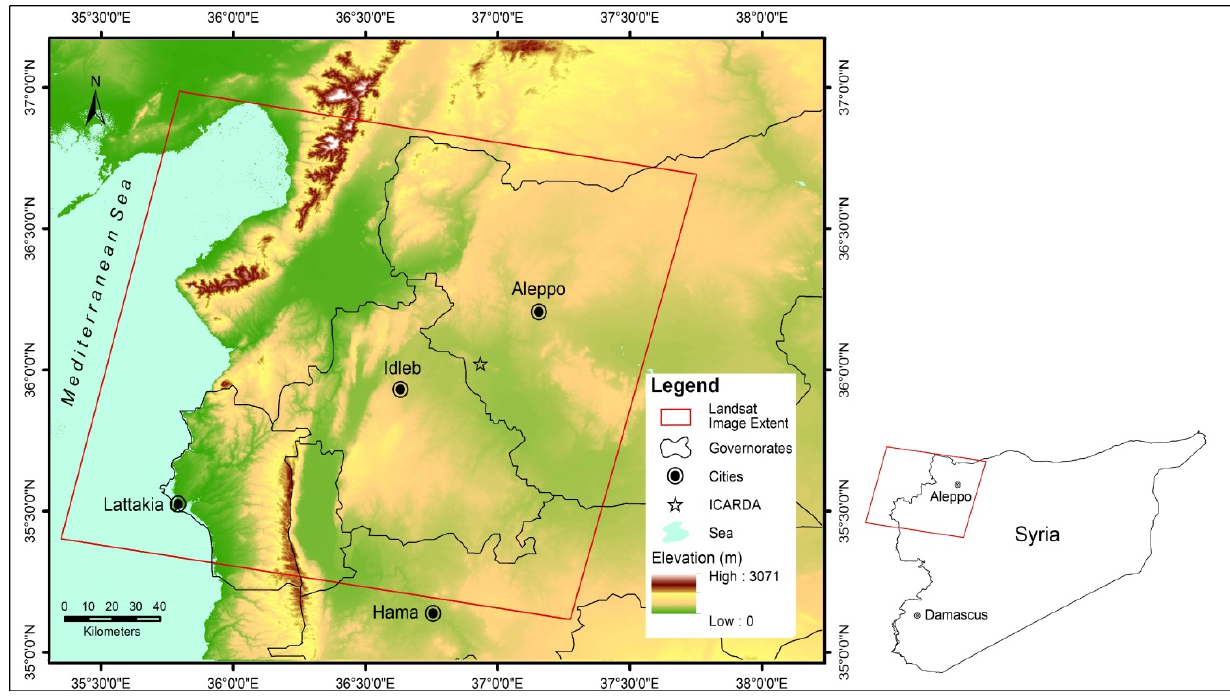
Figure 2. Location of the test area.